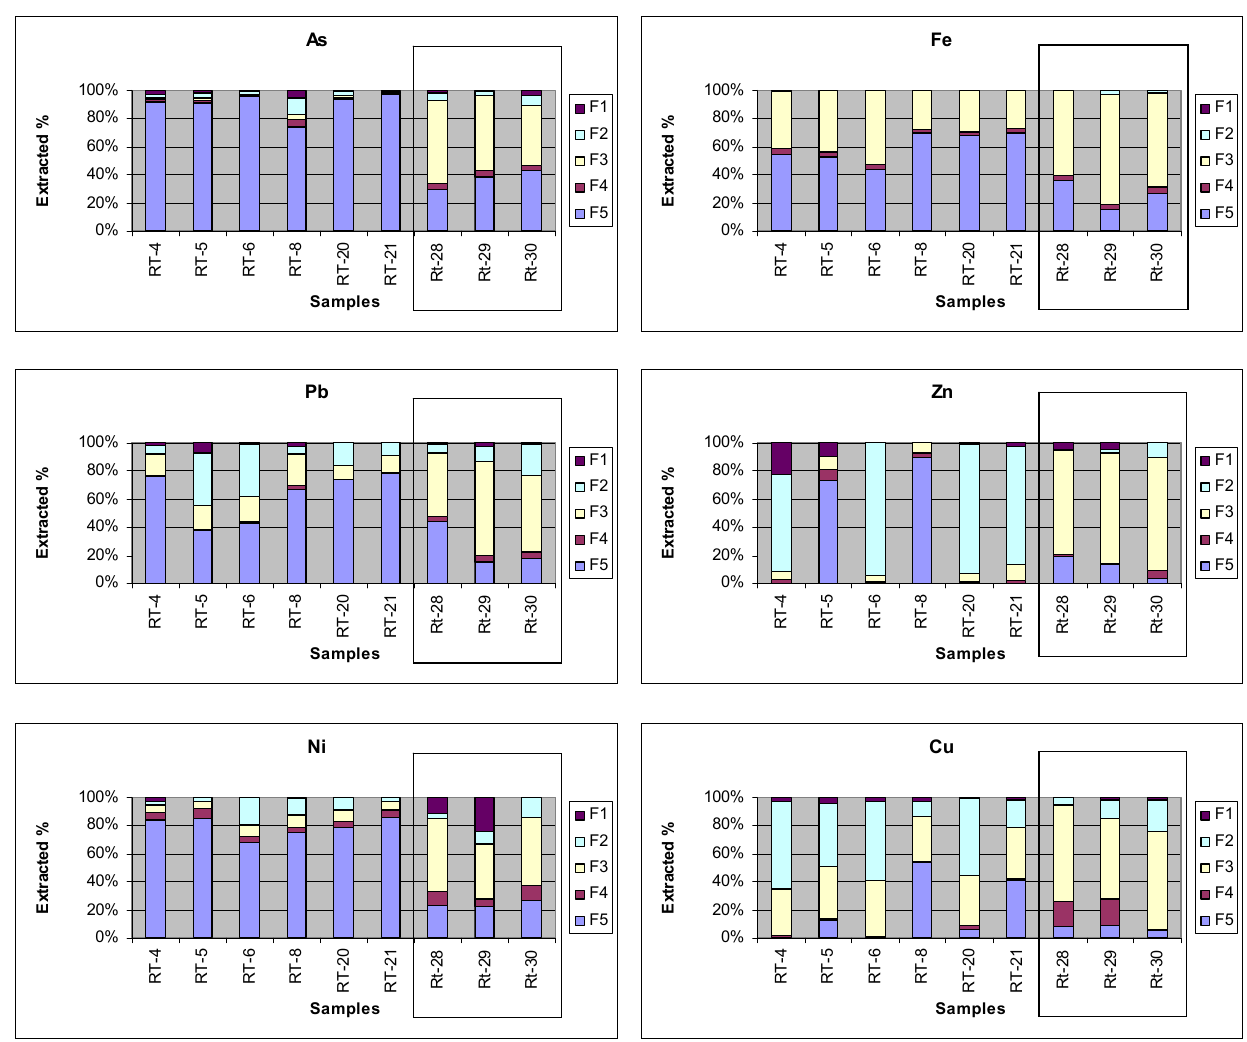
Figure 4. Sequential extraction of several trace elements in selected samples. Samples directly affected by mining wastes or leachates are